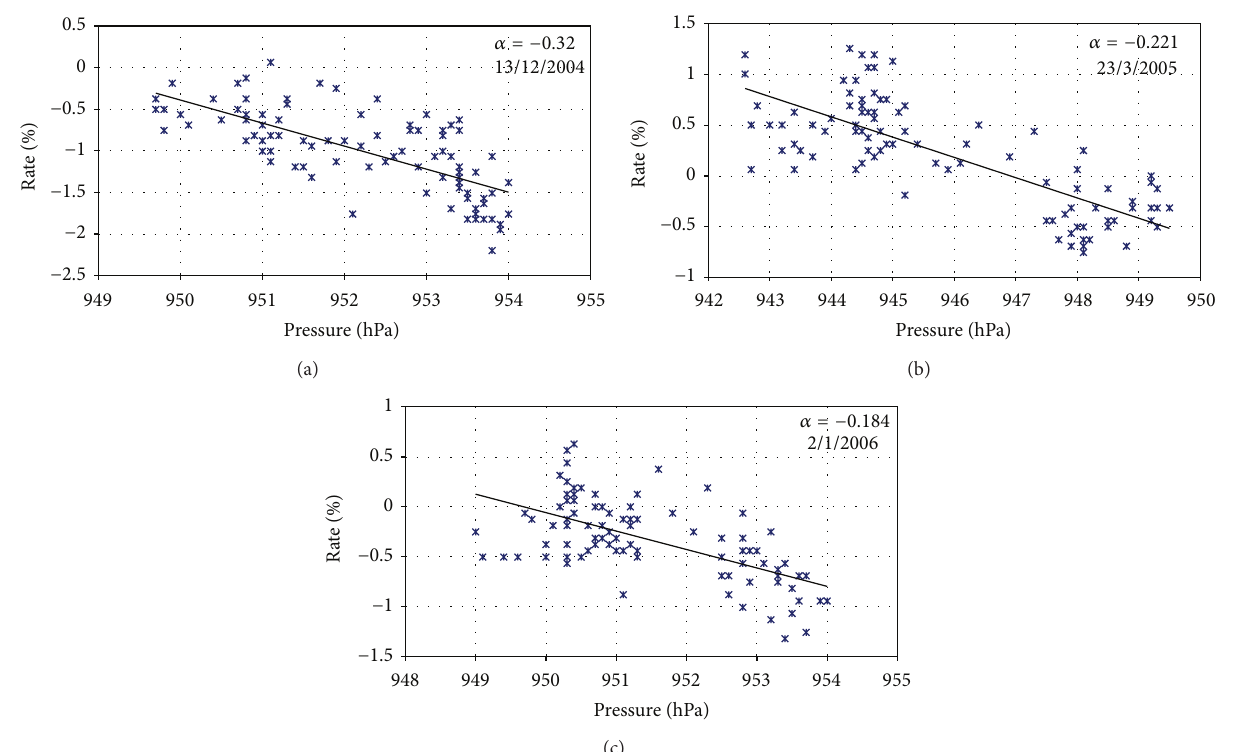
Figure 1: Scatter plot between the pressure and the muon count rate for different days; the straight line is the best fit line in which the slope is the barometric coefficient found in